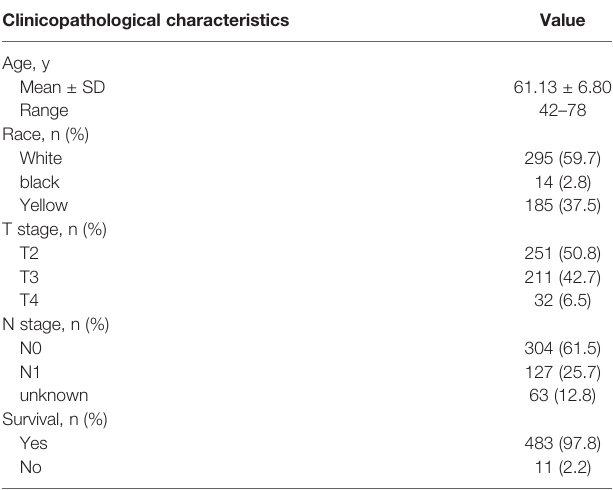
TABLE 3 | Clinicopathological characteristics of 494 patients with PCa from ICGC cohort. Clinicopathological